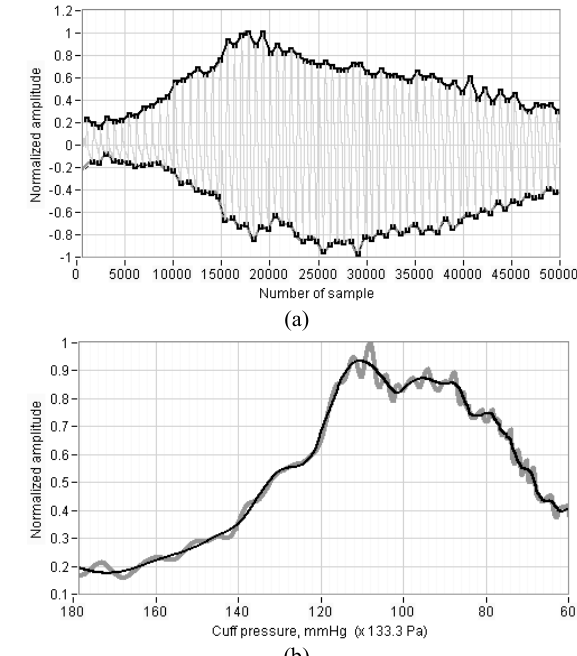
Fig. 4. The upper and lower envelopes of the extracted oscillometric oscillations created by a cubic spline interpolation (a), and the smoothed envelope with respect to cuff pressure (b).